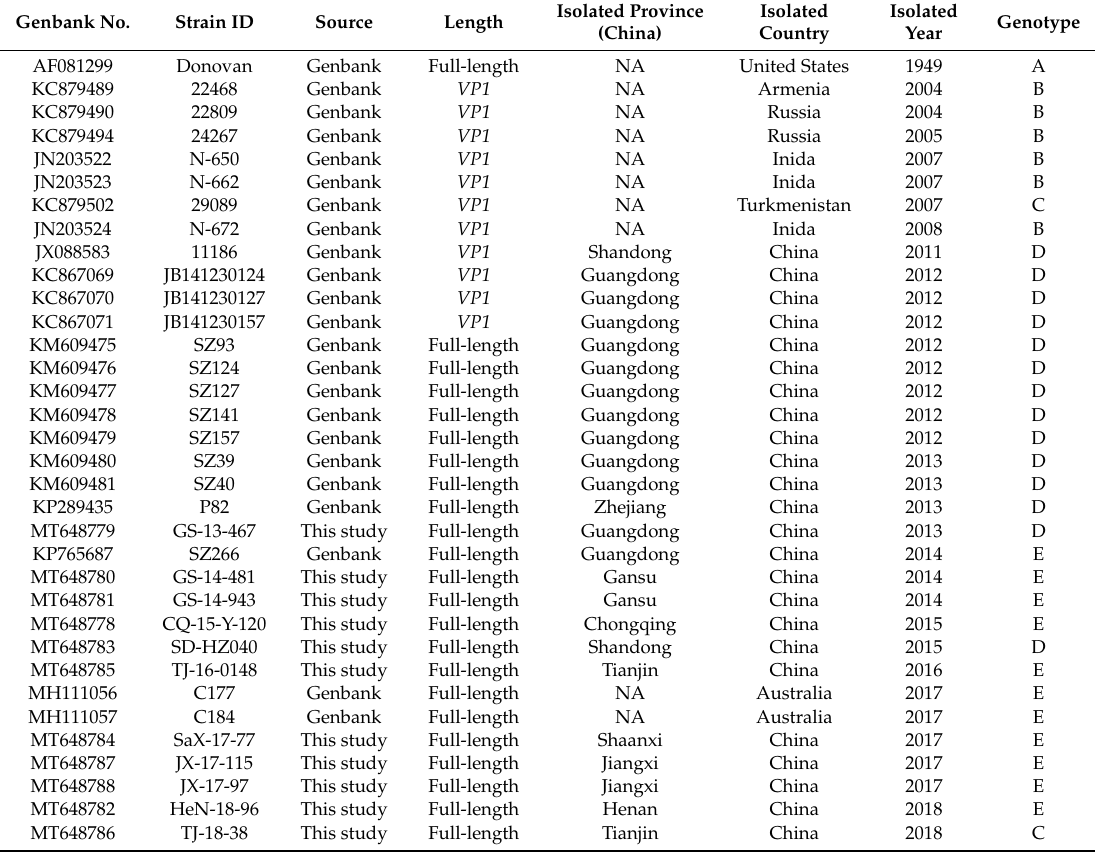
Table 1. Information on 34 coxsackievirus A8 (CV-A8) complete VP1 sequences for genotyping. Genbank